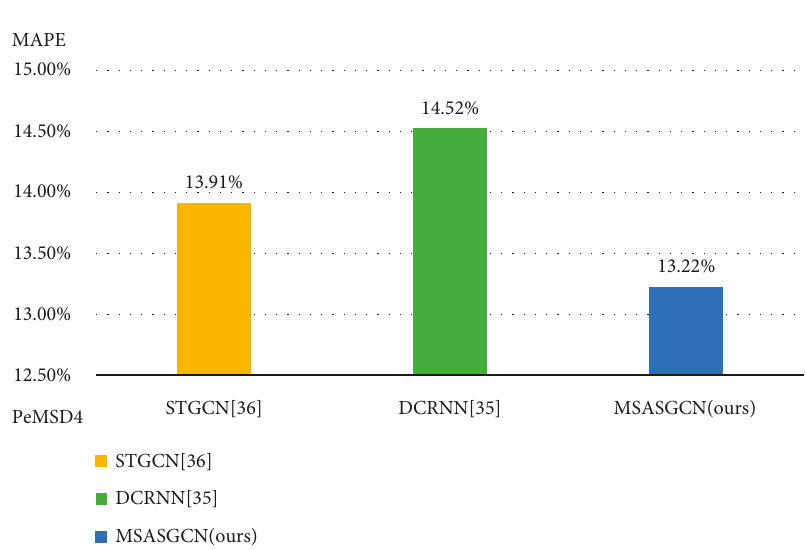
Figure 6: Comparison of different algorithms MAPE on PeMSD4.